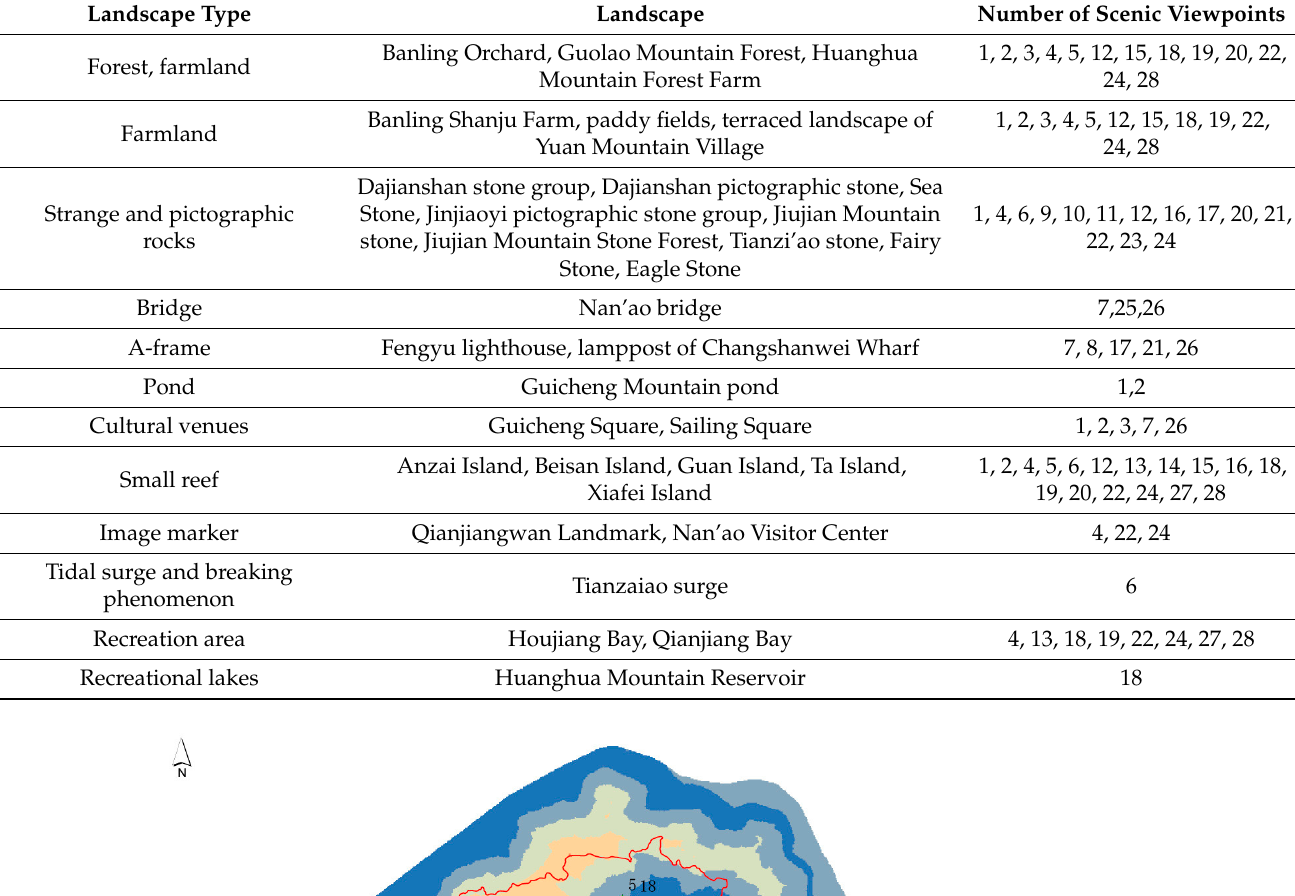
Table 5. Types of landmark landscapes observed in sample plots.